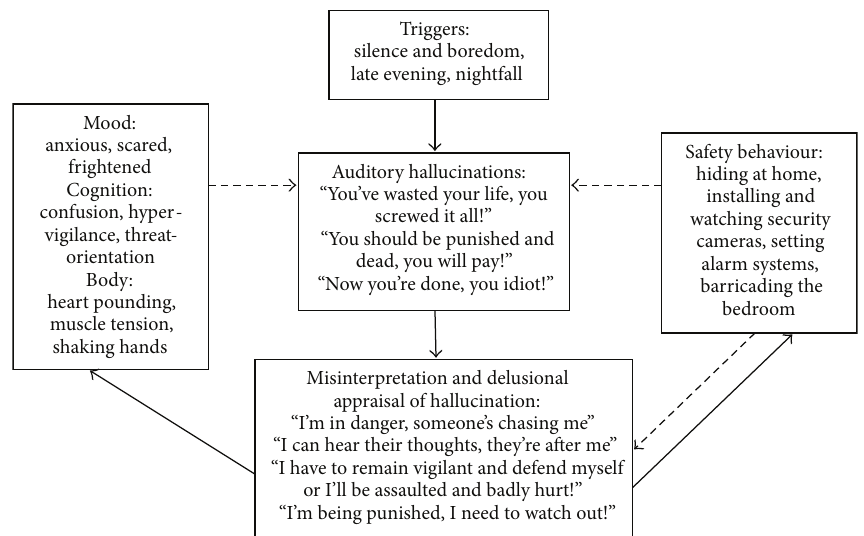
Figure 1: Diagrammatic depiction of case formulation, based on Morrison et al.